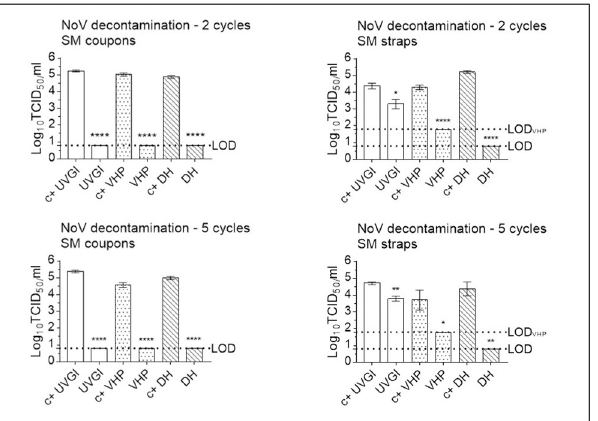
Fig 9. Murine norovirus (MuNoV) inactivation following multiple cycle surgical mask (SM) decontamination using dry heat (DH), vaporised hydrogen peroxide (VHP), and ultraviolet germicidal irradiation (UVGI). Titrations were performed after two or five (three in the case of DH) decontamination treatments on MuNoV- inoculated SM coupons and straps. MuNoV infectivity was analysed in RAW264.7 cells. The cell culture limit of detection (LOD) was 0.80 log10 TCID 50 /mL (6.31 × 10 0 TCID 50 /mL) for all analyses except those concerning VHP- treated SM straps (1.80 log10 TCID 50 /mL (6.31 × 10 1 TCID 50 /mL)). Per decontamination method, nine PRCV- inoculated, decontaminated coupons (n = 9) and three inoculated, decontaminated straps (n = 3) were analysed in parallel to inoculated, untreated, positive control (c+) coupons (n = 9) and straps (n = 3). Mean log10 TCID 50 /mL and standard errors of the means are represented. P-values were computed by using a two-sided independent sample t-test, where ���� P < 0.0001, ��� P < 0.001, �� P < 0.01, � P < 0.05, and ns is P � 0.05. DH, reducing viral titres by over three orders of magnitude (3.96 log reduction), and by over 10 four orders of magnitude for VHP- and UVGI-treated FFR coupons (4.42, and 4.44 log 10 reduction, respectively). UVGI- and DH-treatment of FFR straps reduced infectivity by 0.06